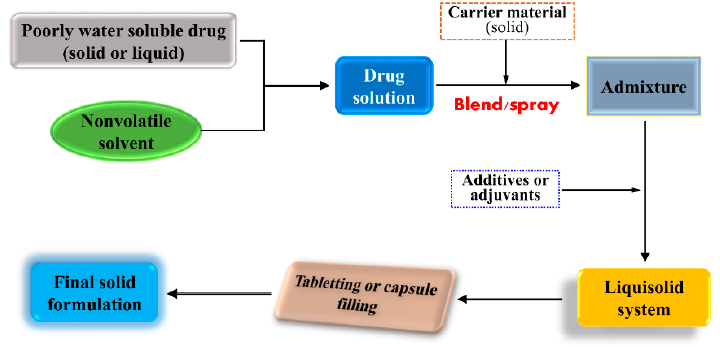
Figure 5. Formulation strategy of poorly water soluble drugs using the liquisolid dispersion technique.